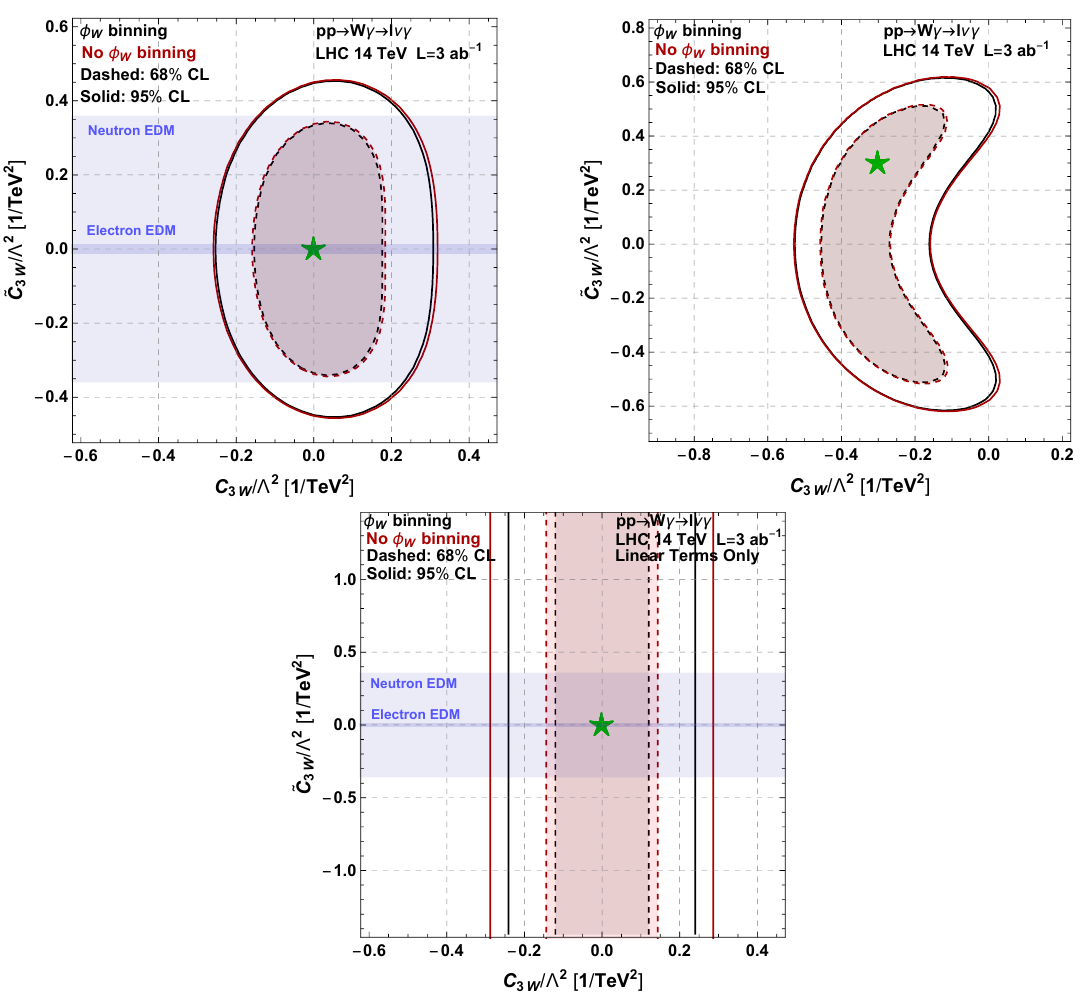
Figure 8 . 68% (dashed) and 95% (solid) posterior probability contours for the analysis with (black) and without (red) the binning in then (cid:30) W angle, see main text for more details. The left and right hand upper plots are obtained assuming the SM and a BSM signal with (cid:0) c 3 W = ~ c 3 W = 0 : 3, both represented by a green star. The light and dark shaded blue correspond to the limits obtained by the non observation of a neutron and electron EDM discussed in section 5. On the lower plot for illustration purposes we present the exclusion contours assuming only the linear terms in the EFT expansion. Only events with M W(cid:13)